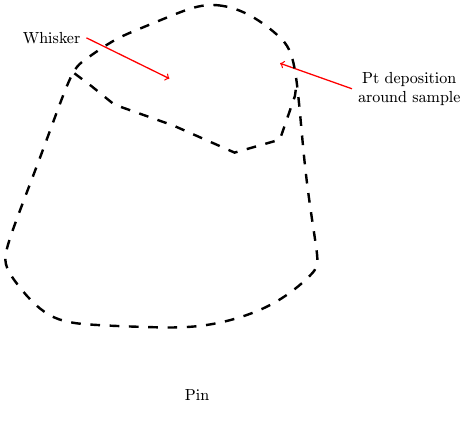
Figure 1. The studied whisker after being lifted out and mounted on a pin using FIB. The sample comprises a 7µm thick layer of tin deposited on a copper substrate and aged in room temperature for twelve months. The whisker is located in the centre of the sample. The surface of the sample was protected from redeposition during FIB-milling by depositing platinum walls around the whisker. The milled out cylinder was extracted from the substrate using a nanomanipulator and attached to a tungsten pin. The dashed line indicates the perimeter of the extracted